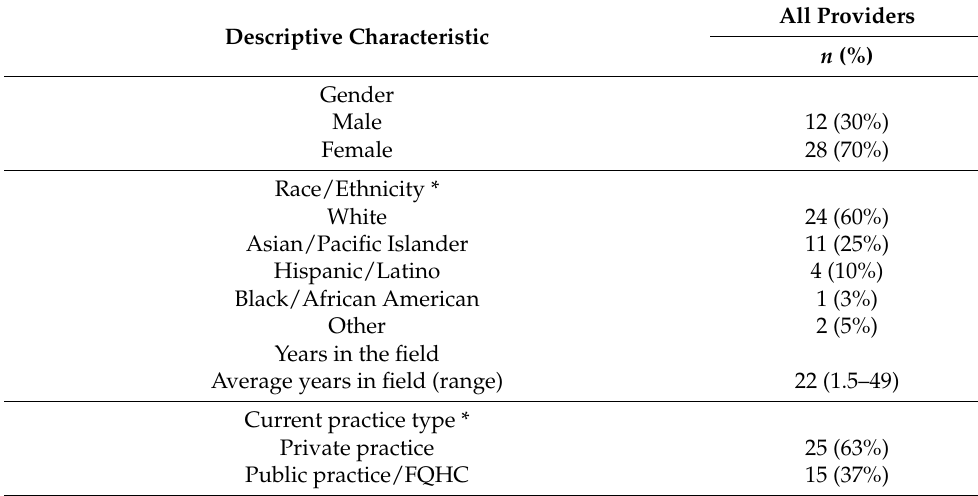
Table 1. Provider demographics and communication background ( n =